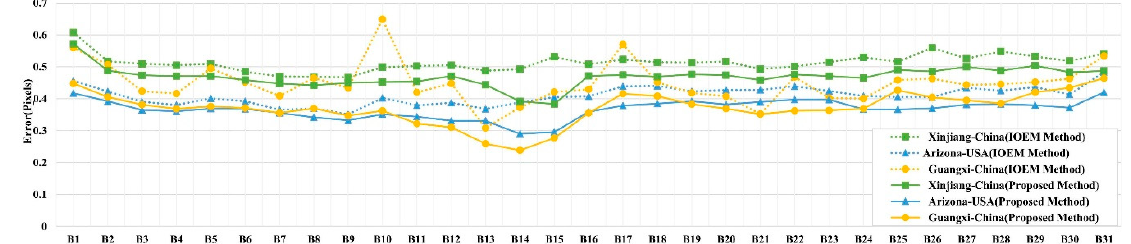
Figure 12. Registration accuracy of adjacent bands using different methods.